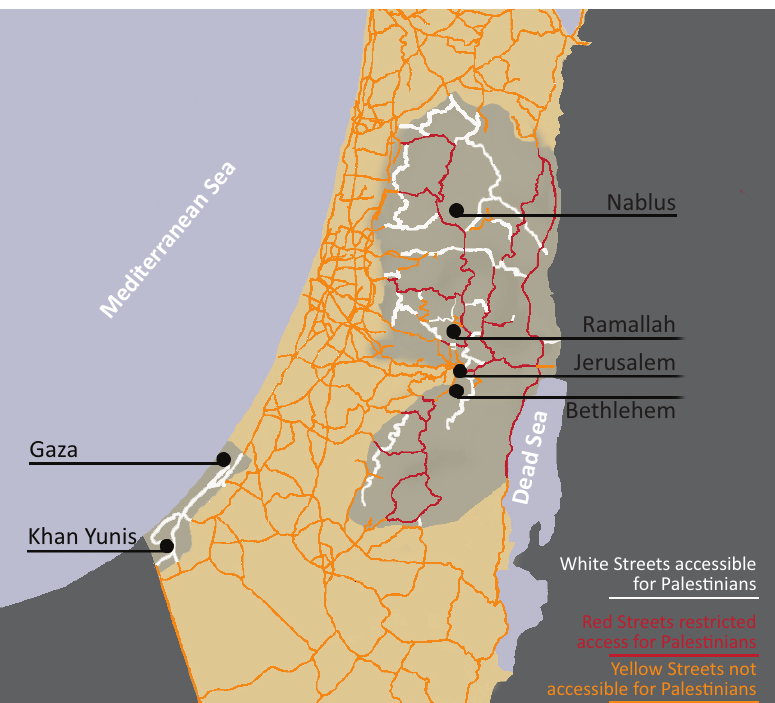
Figure 5. The segregated road-network exacerbates the daily life and practices of the Palestinian population (illustration by authors, based on data from visualisingpalestine.com and ISOCARP,